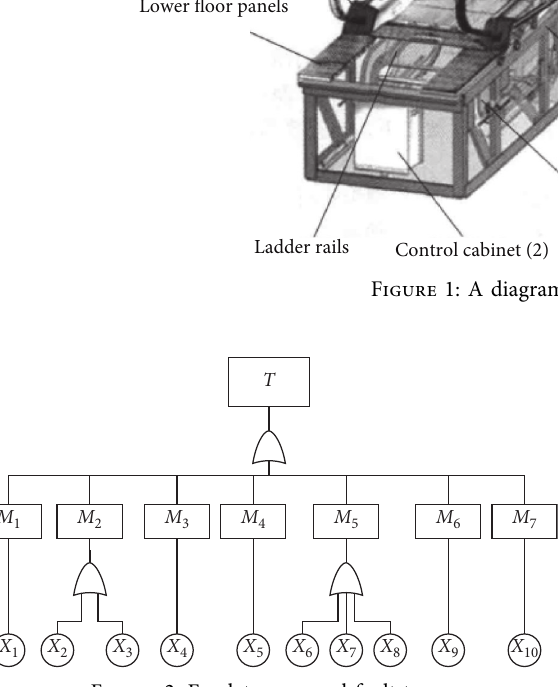
Figure 2: Escalator reversal fault tree.